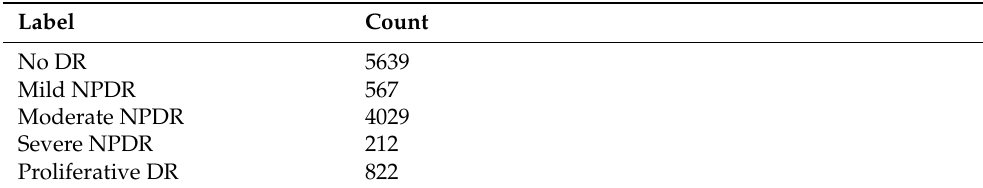
Table 4. Distribution of classes in the DDR dataset